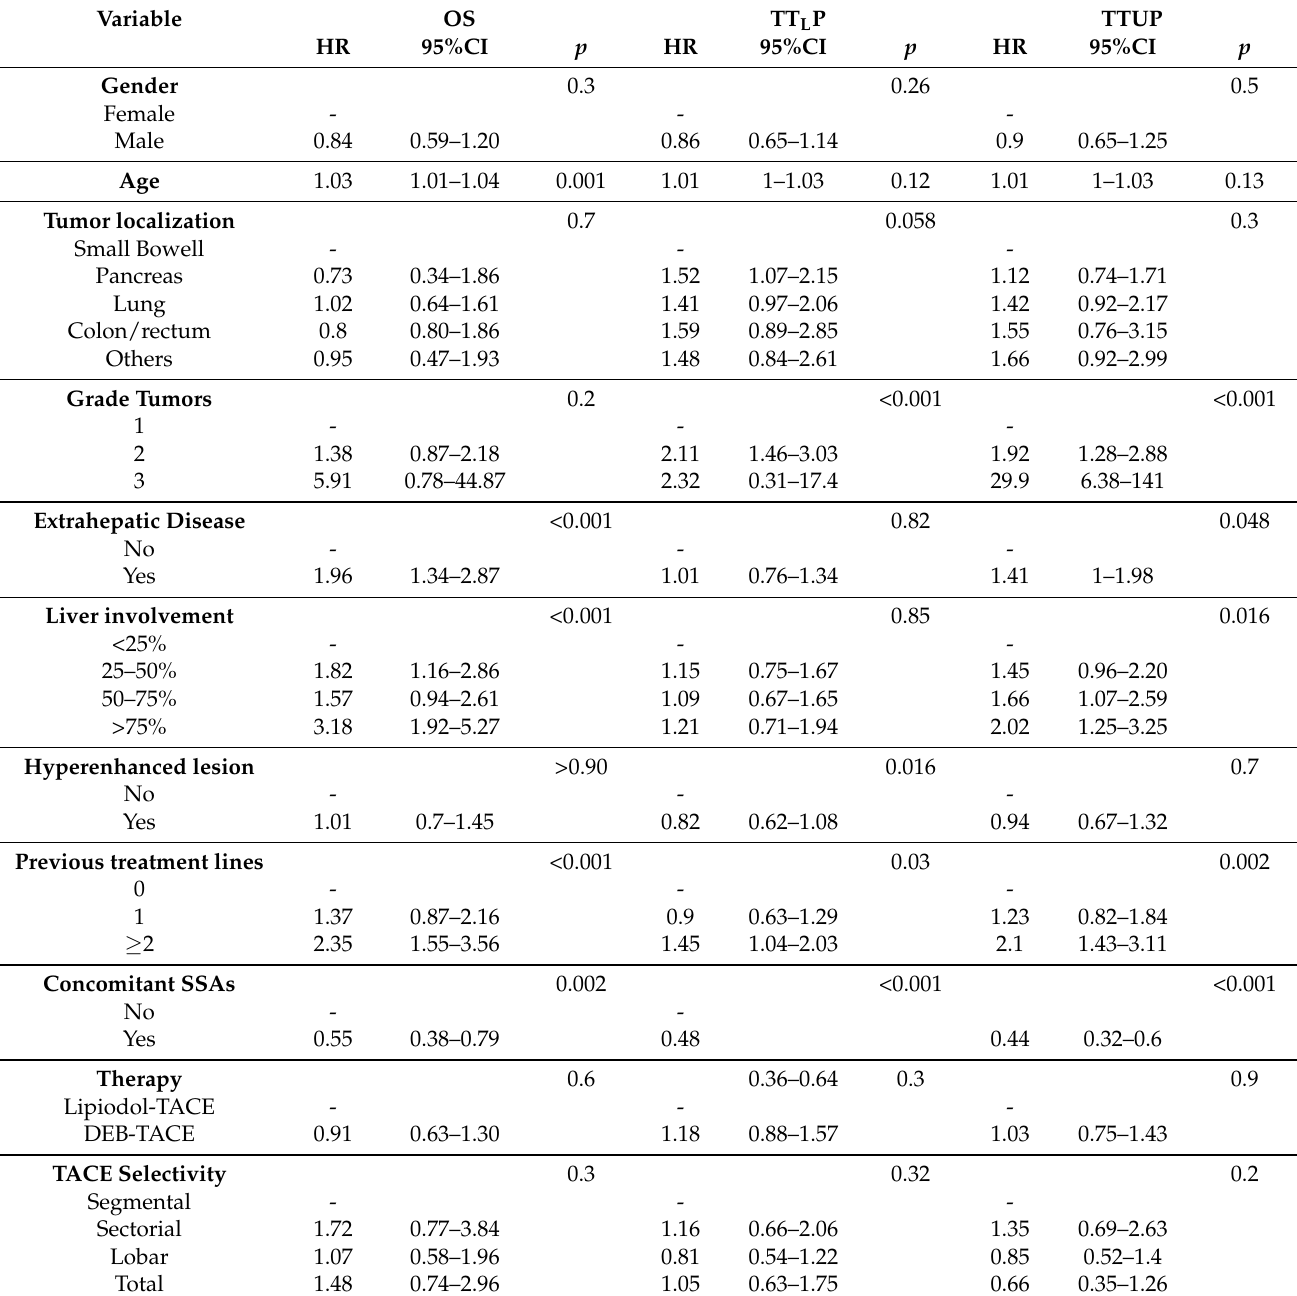
Table 5. Prognostic factors for TT L P. TTUP and OS—Univariate